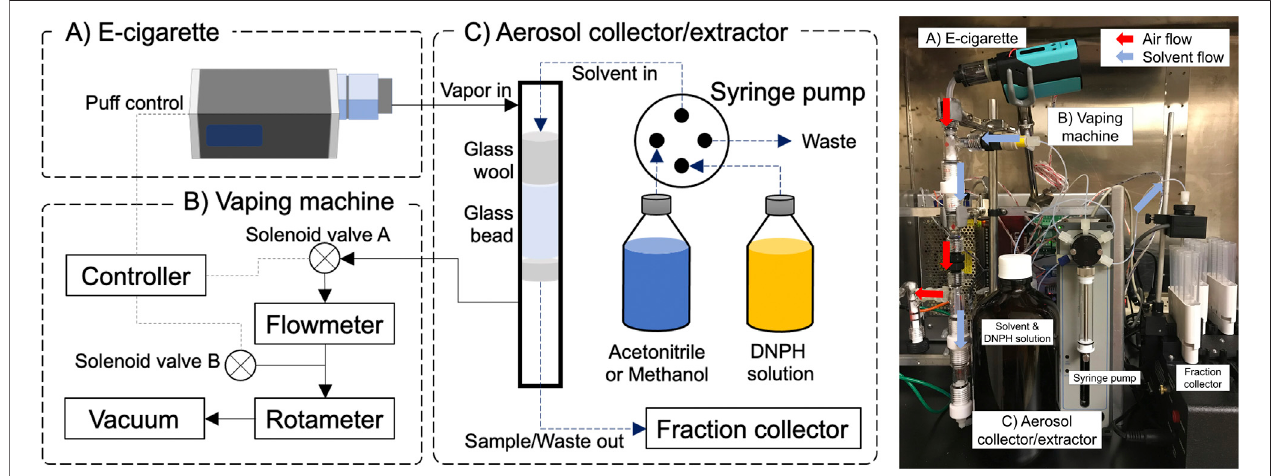
FIGURE 1 | The E-cigarette aerosol collection and extraction system